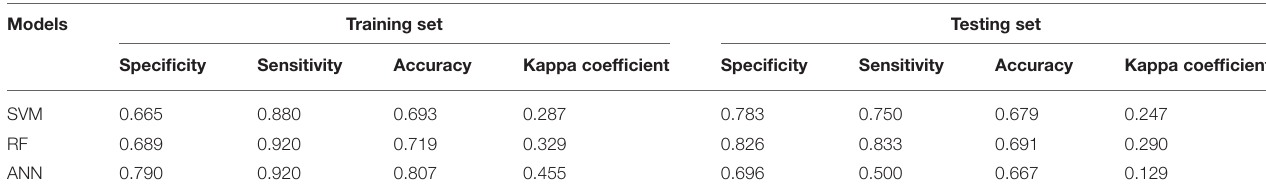
TABLE 2 | Performance indicators of confusion matrix in training and testing sets. Models Training set Testing set Specificity Sensitivity Accuracy Kappa coefficient Specificity Sensitivity Accuracy Kappa